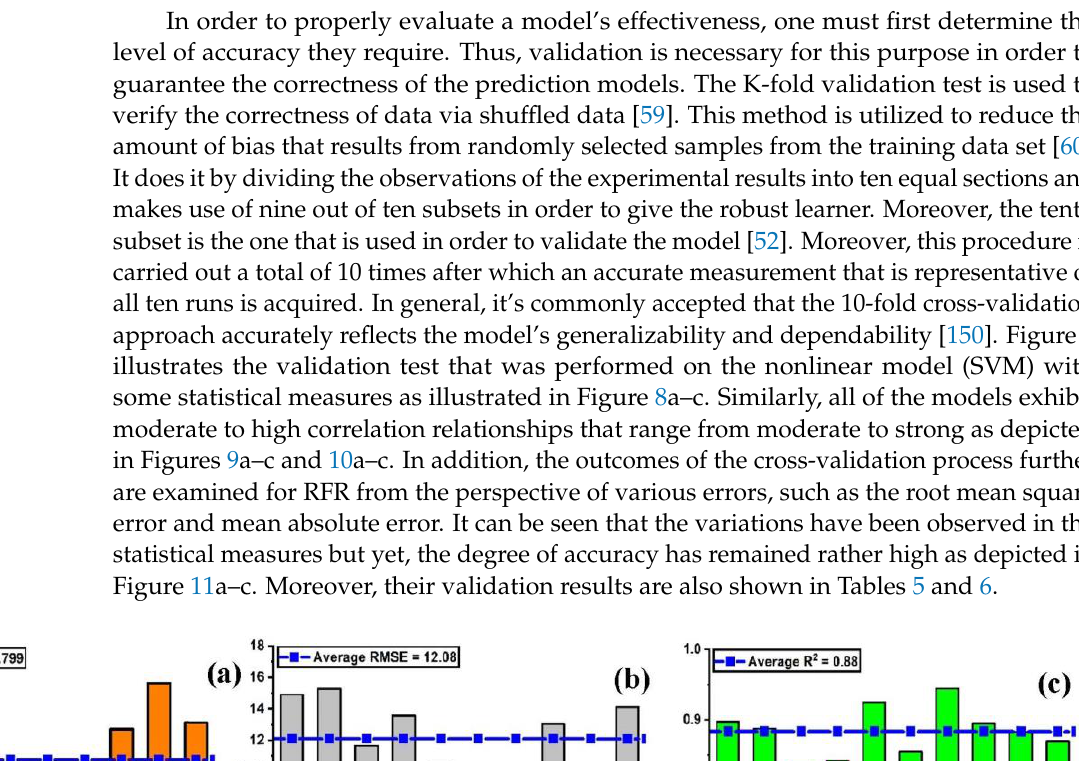
Figure 7. Random forest model; ( a ) regression analysis of experimental and predicted models; ( b ) distribution error of RF model.